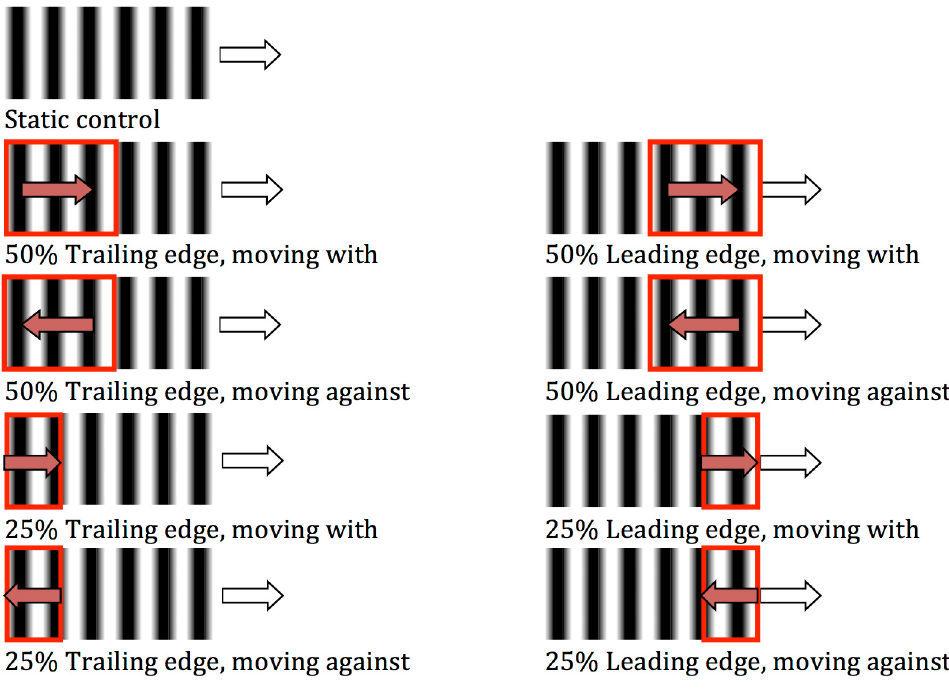
Fig 3. Conditions for Experiment 3. White arrow indicates direction of target and red arrow indicates direction of dynamic texture motion. Red rectangle indicates the proportion of the texture that is moving. The remainder of the texture is